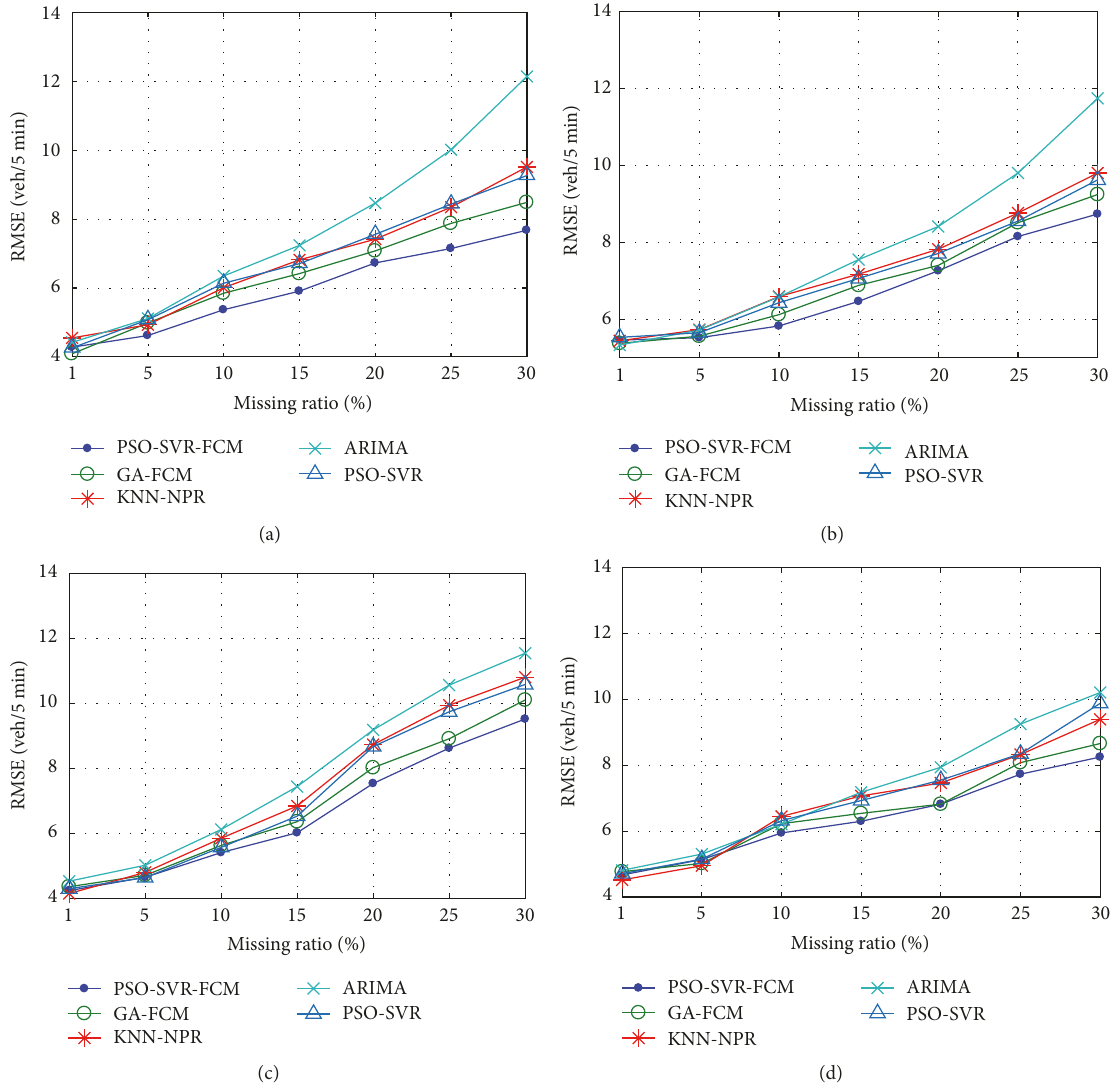
Figure12:TheRMSEcurveofeachmethodforcomparisoninMCRpattern,usingthetrafficdatacollectedfromthedetectors(a)NBXX13 (2) , (b) NBXX11 (4) , (c) DC00004964(E2), and (d)